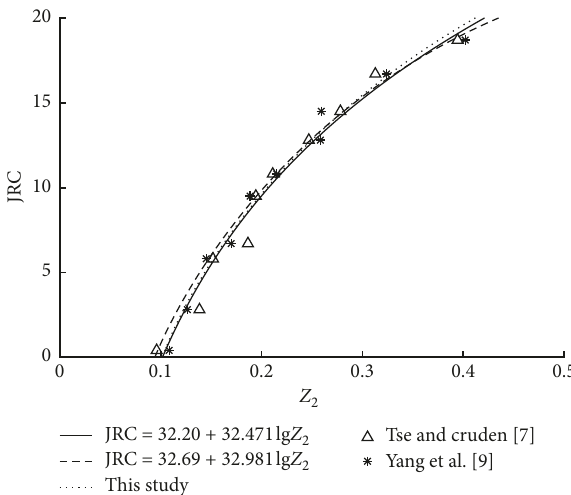
Figure 6: Relationship between the JRC and Z